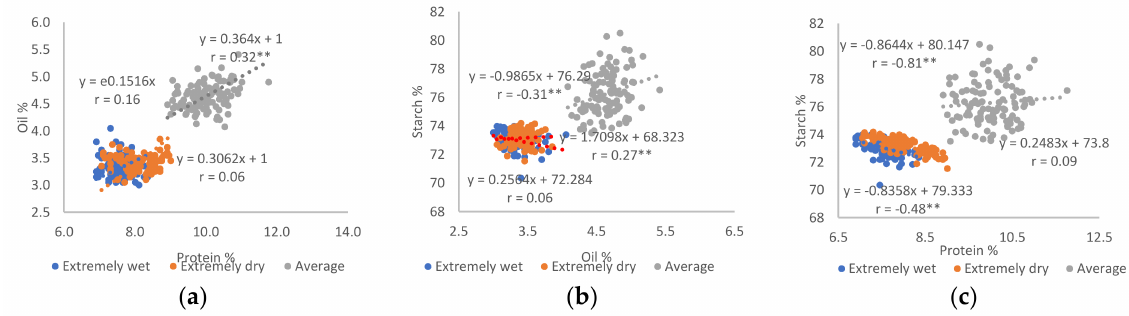
Figure 8. Relationship between ( a ) protein and oil (%), ( b ) starch and oil (%), and ( c ) protein and starch content (%) in different weather conditions (extremely wet, extremely dry, and average) significantly different at p < 0.05 (*) and p < 0.01 (**).